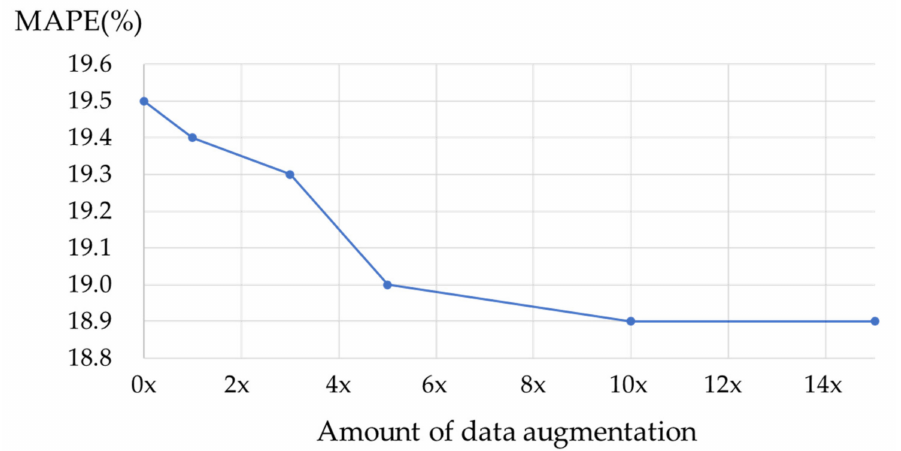
Figure 9. The relationship between the amount of data augmentation and overall detection per- formance (closed food and hybrid CTC/attention model): Five-class detection (left chewing, right chewing, front biting, swallowing, and